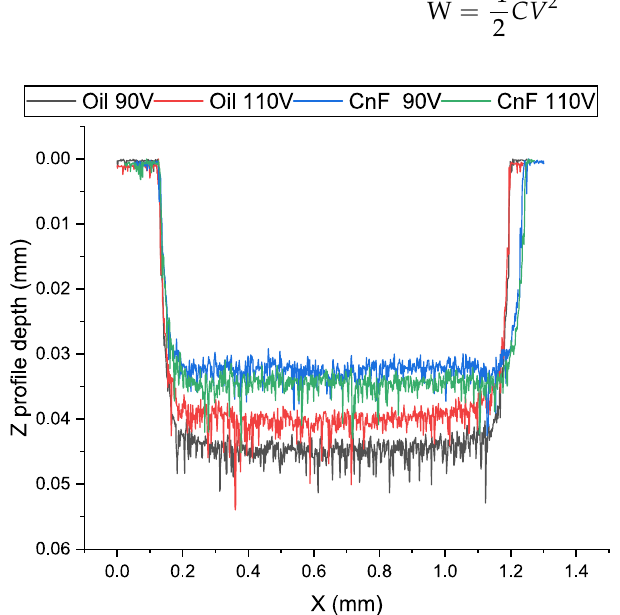
Figure 8. Profiles of machined holes at 90 and 110 V using oil and 0.5 g/L CnF-mixed EDM.